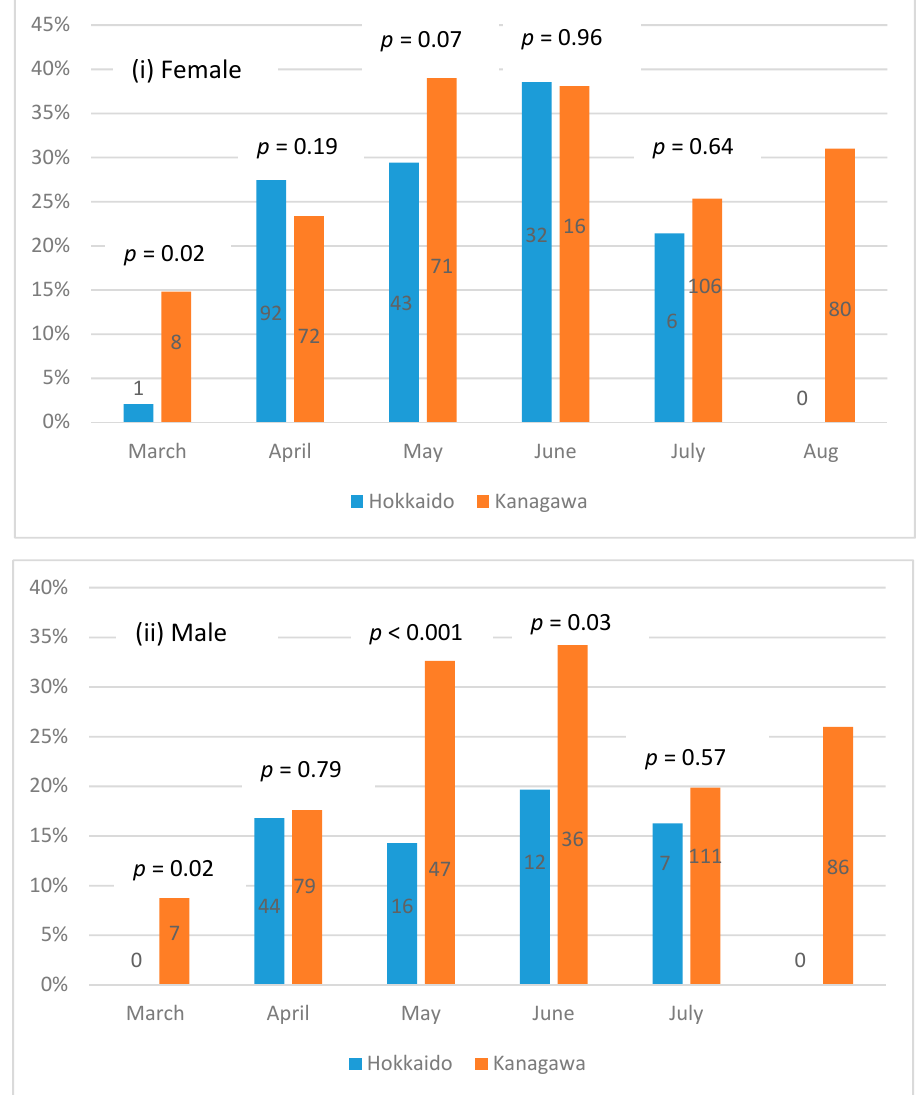
Figure 3. Proportion and Number of Asymptomatic Patients by Prefecture, Month, and Sex. The number of asymptomatic patients of each sex, in Hokkaido and Kanagawa, is shown for each month.